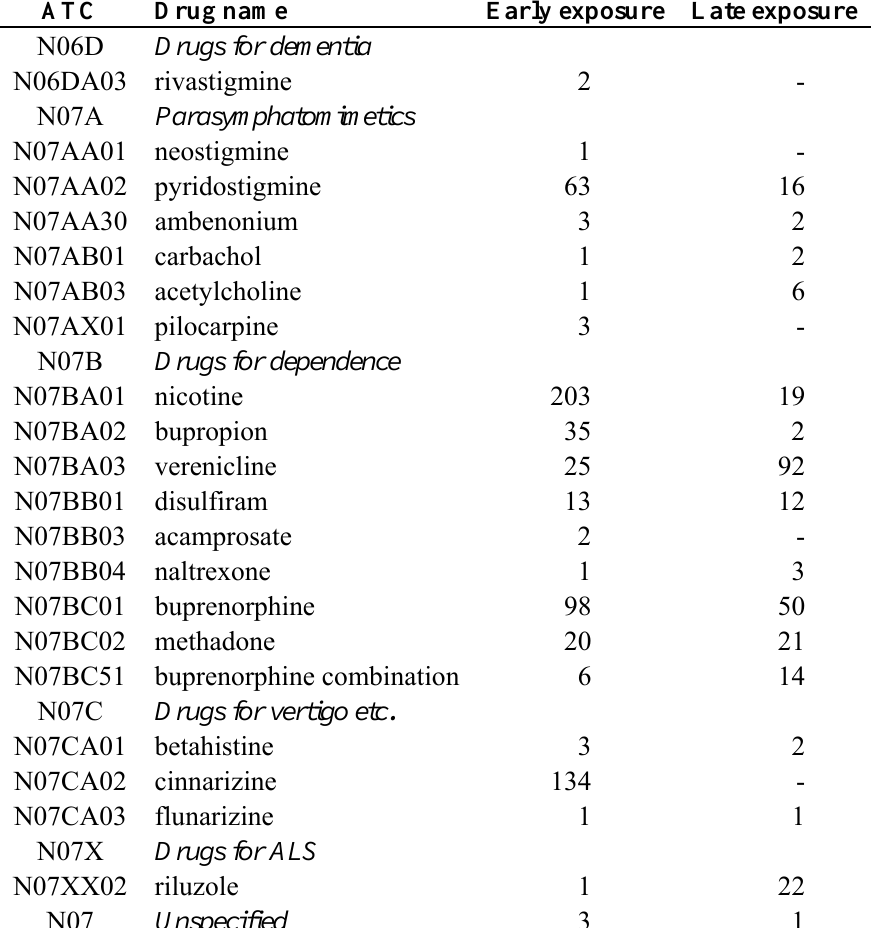
Table 40. Number of infants exposed in early pregnancy to “other CNS-active drugs” or were born to women who filled prescriptions for such drug during then 2nd or 3rd